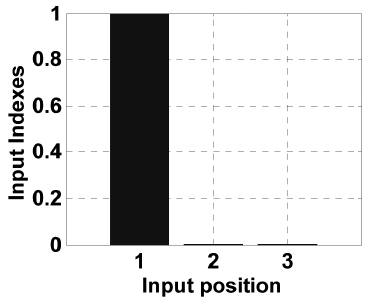
Fig. 10. Input index calculated using Eq. (14) for each of the excitation positions – experiments. Damage was simulated by adding 16 g mass at position 1. This should be compared with Fig. 4a, in which, the input position 1 corresponds to actuator position 1, input position 2 corresponds to actuator position 4 and input position 3 corresponds to actuator position